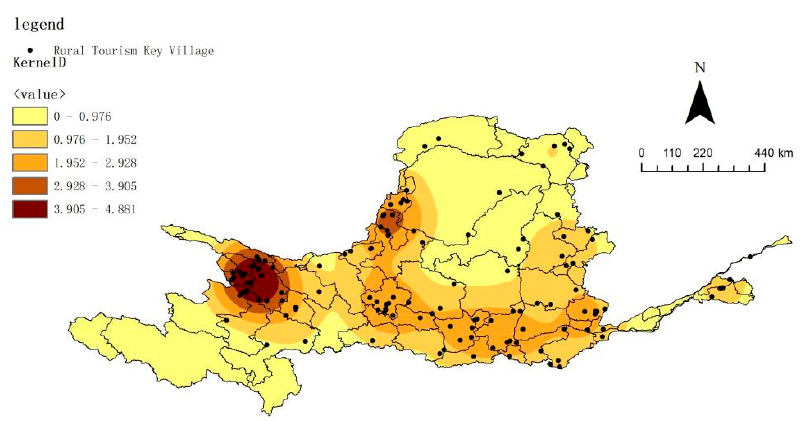
Figure 3. Kernel density map of key rural tourism villages in the Yellow River Basin.